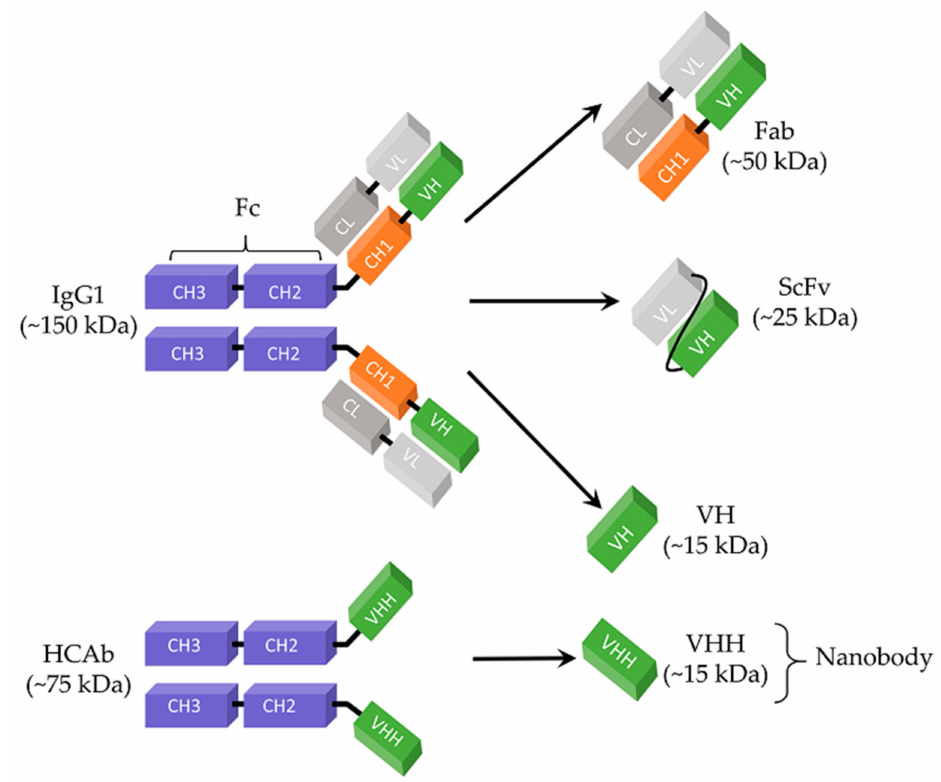
Figure 1. Schematic representation of antibodies and antibody fragments. IgG1, immunoglobulin G1; HCAb, heavy chain-only antibody; Fc, crystallizable fragment; Fab, antigen-binding fragment; ScFv, single-chain variable fragment; CH1–CH2–CH3, constant domains of heavy chain; CL, constant domain of light chain; VH, variable domain of heavy chain; VL, variable domain of light chain; VHH, variable heavy chain of